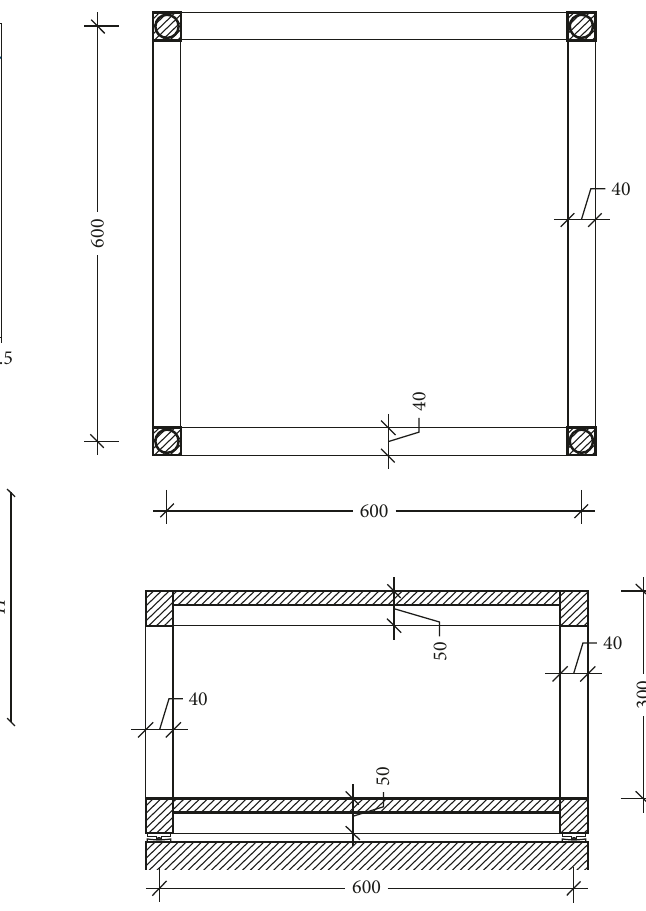
Figure 11: Four-column frame (dimensions in cm).